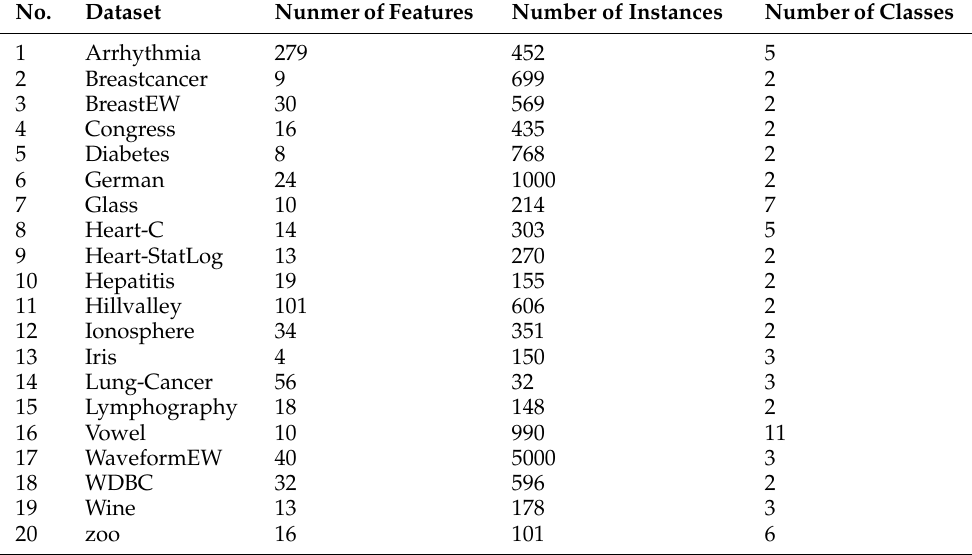
Table 2. Details of Used Datasets.